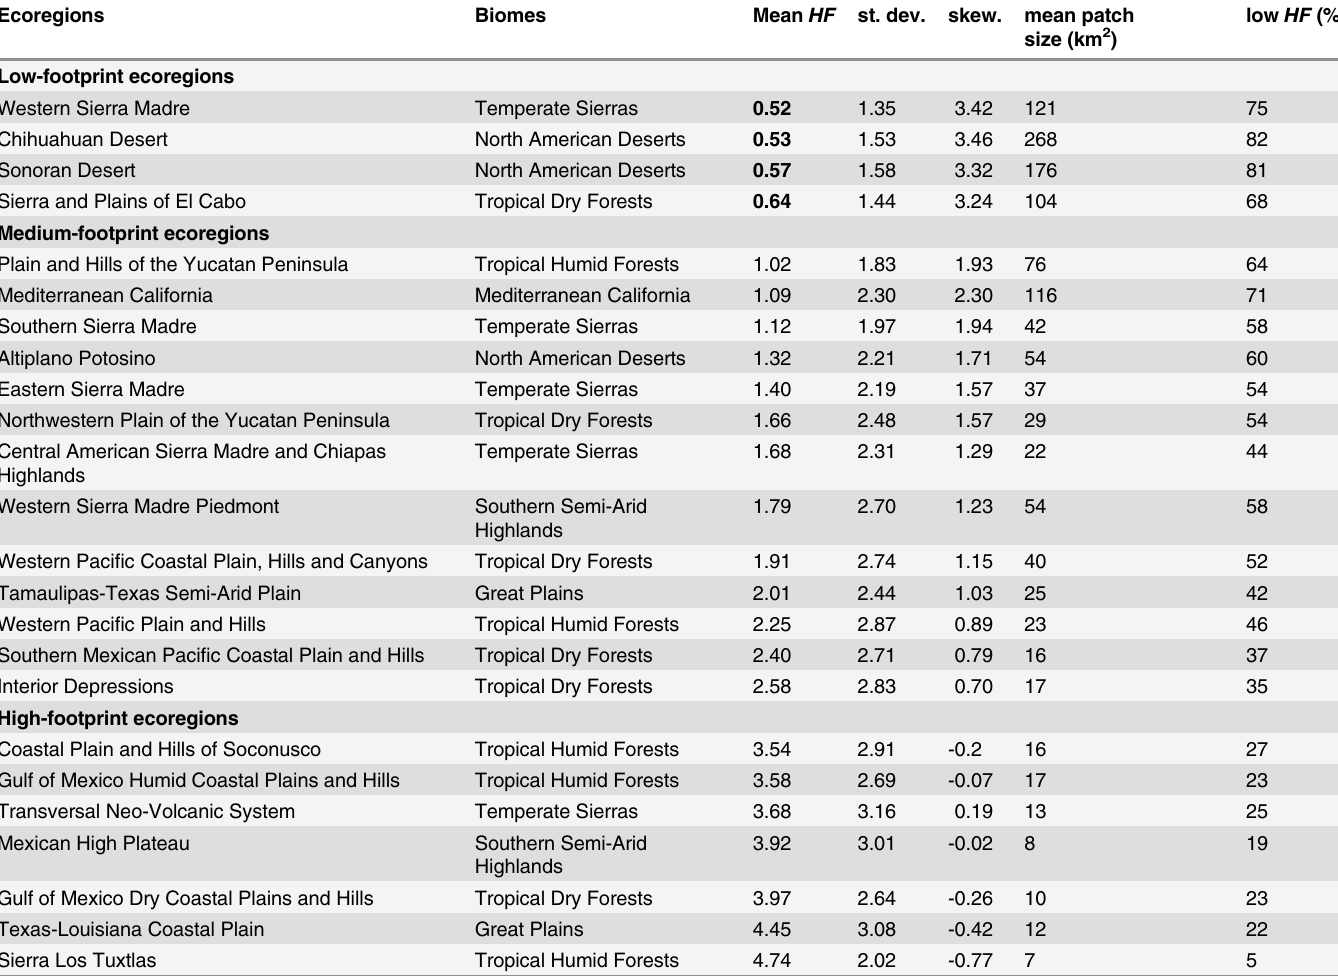
Table 2. Ecoregions of Mexico ordered according to their mean footprint value.